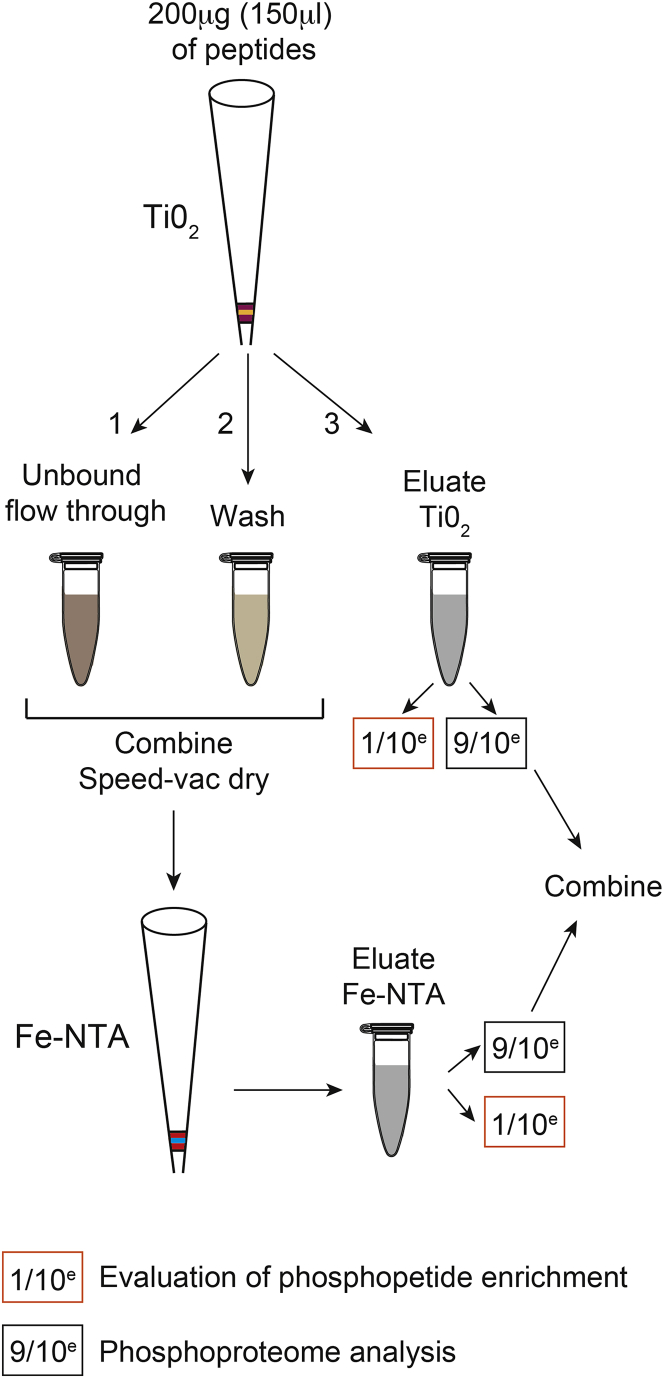
SMOAC Strategy—Combination of TiO2 and Fe-NTA Phosphopeptide Enrichment Kits